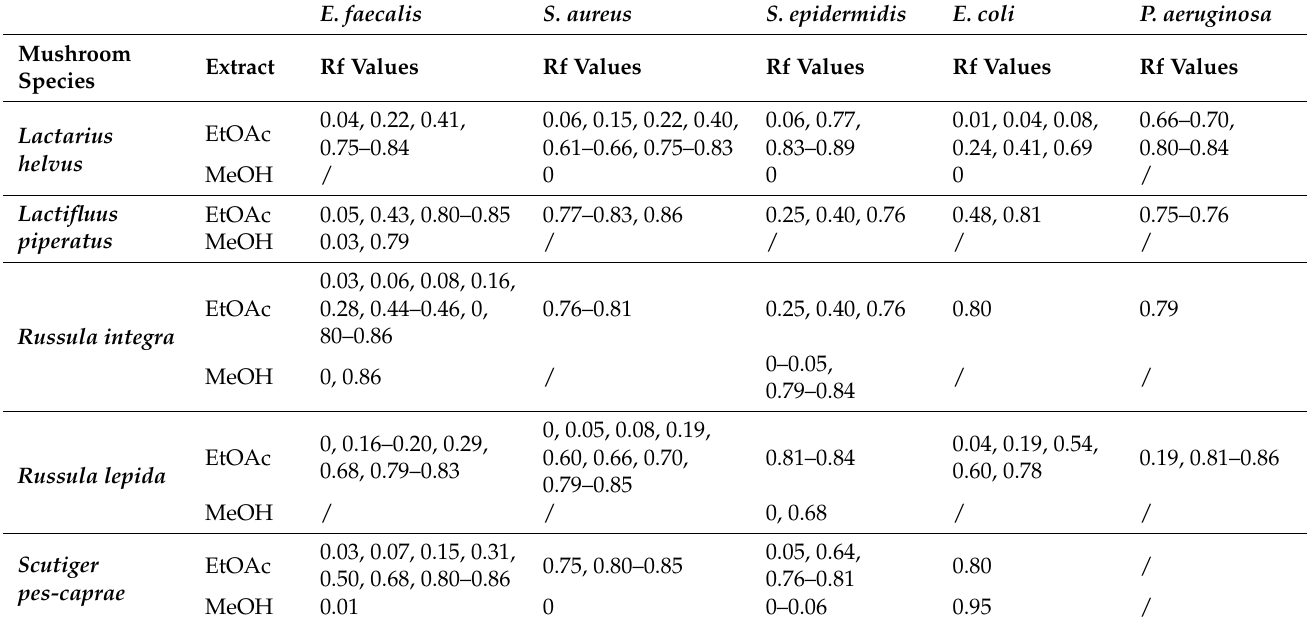
Table A7. Antibacterial activity induced by Russulales mushrooms against wild-type bacteria ex- pressed as Rf values of inhibition